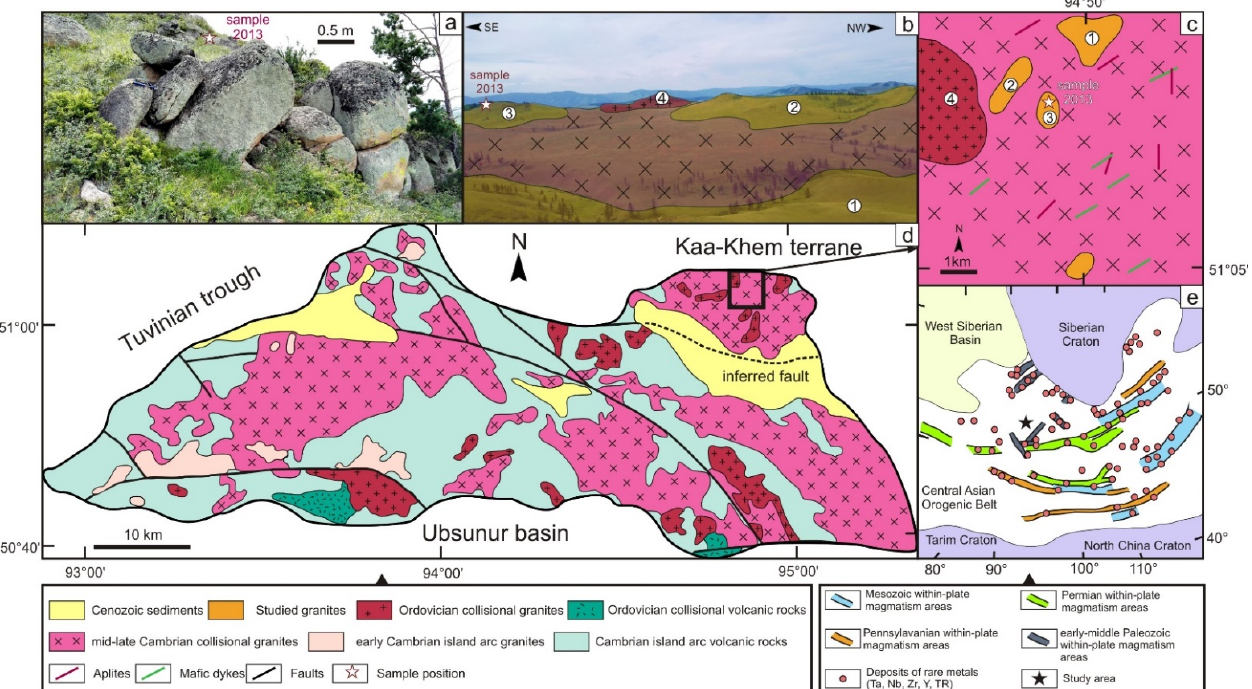
Figure 1. ( a , b ) Field photographs of the peralkaline granitic massifs within the Tannuola terrane; ( c ) Simplified geological map showing the study area and sample location; ( d ) Simplified geological map of the Tannuola terrane; ( e ) Deposits of rare metals of the Central Asian Orogenic Belt after